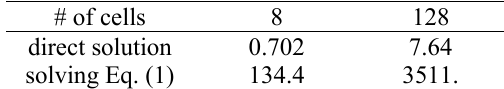
Table 1: The computation time of ADSMs (sec).